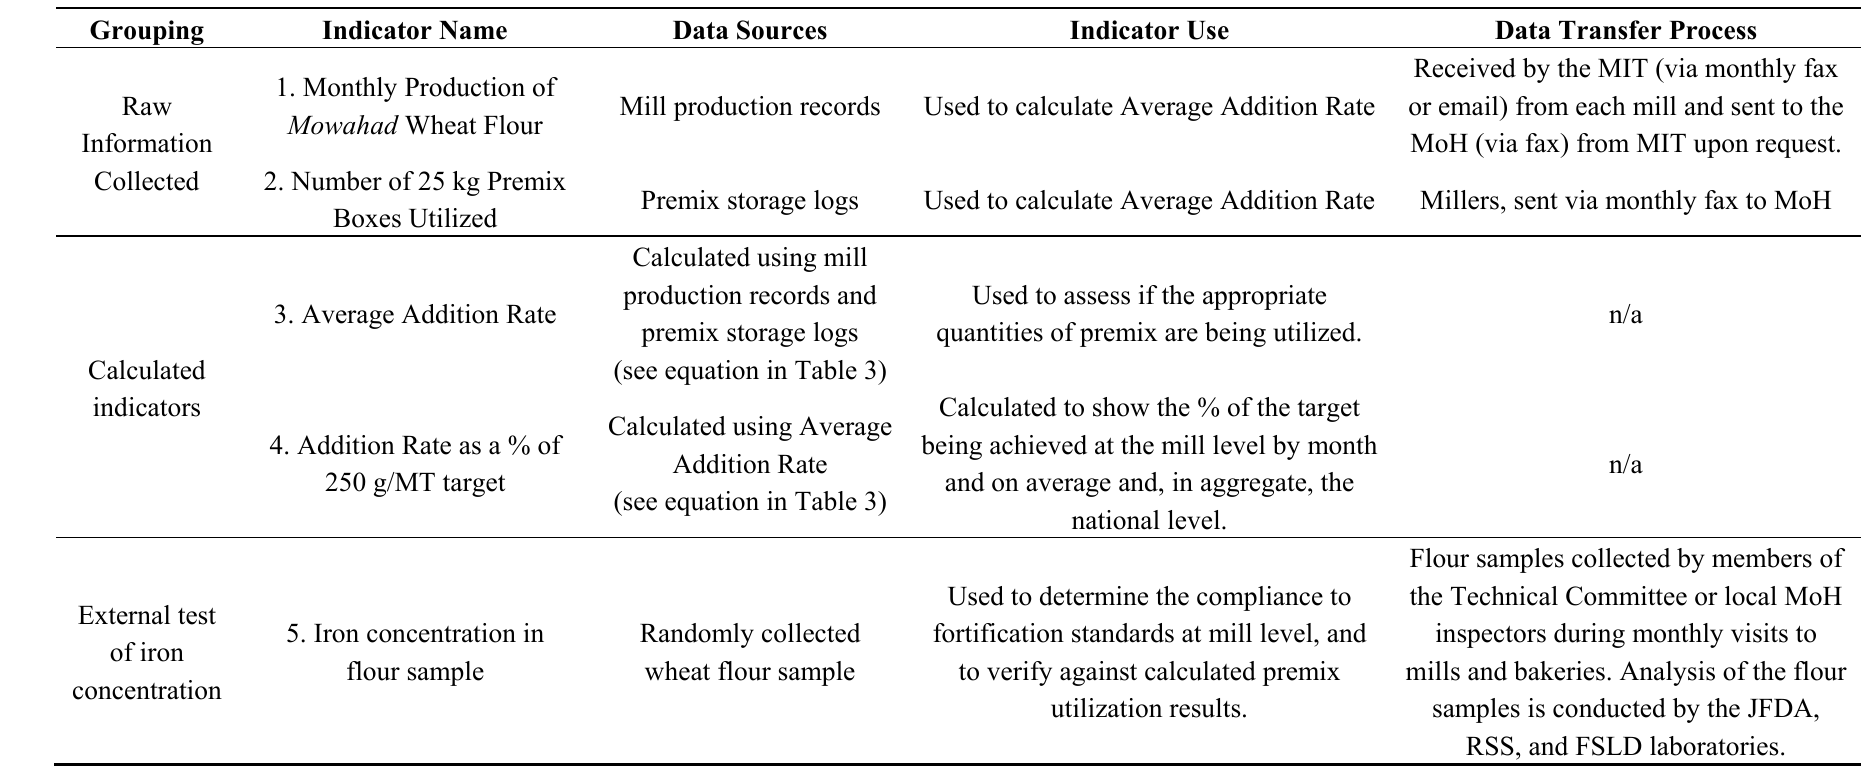
Table 2. Monthly food fortification monitoring